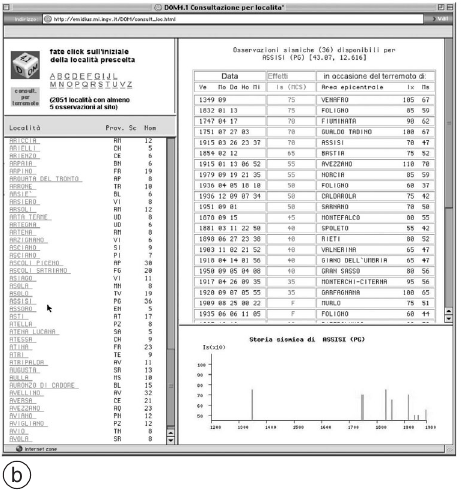
Fig. 1a,b. DOM query by earthquake (a), by local- ity